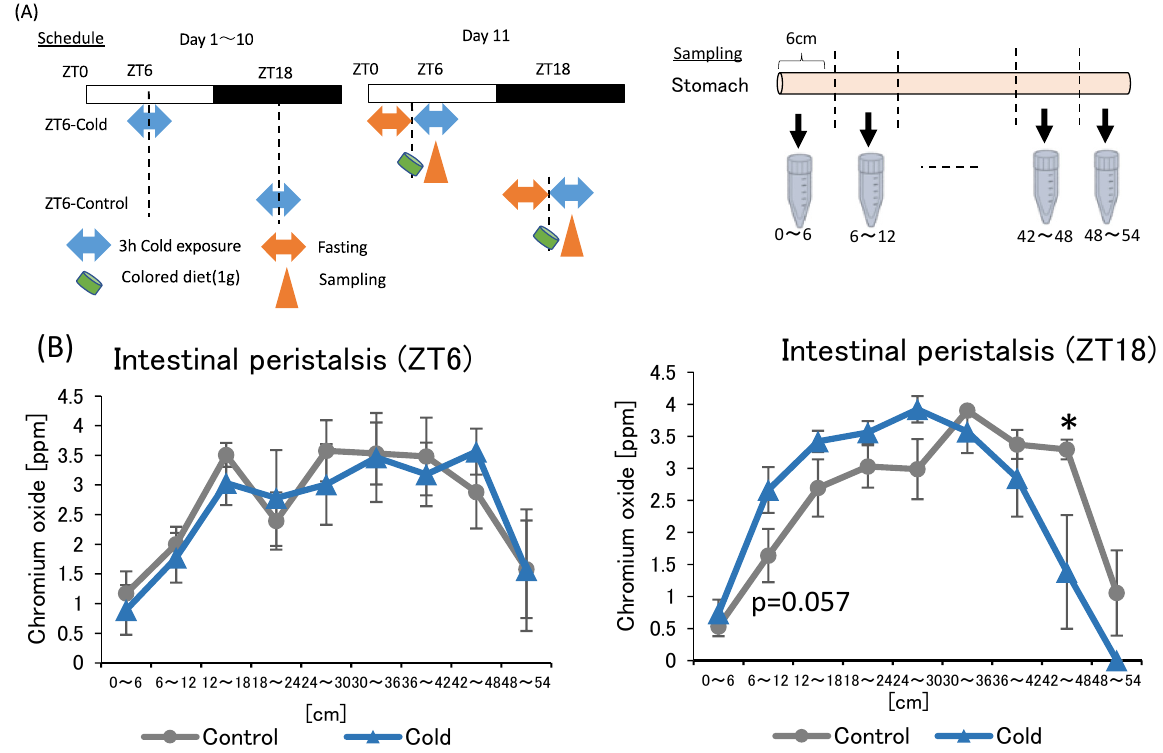
Figure 5. Effects of cold exposure on intestinal peristalsis. ( A ) Experimental design; ( B ) peristalsis movement of mice exposed to 22 or 7 °C for 3 h a day for 10 days. Data are represented as mean ± SEM ( n = 5–7). * p < 0.05 evaluated using t -test.